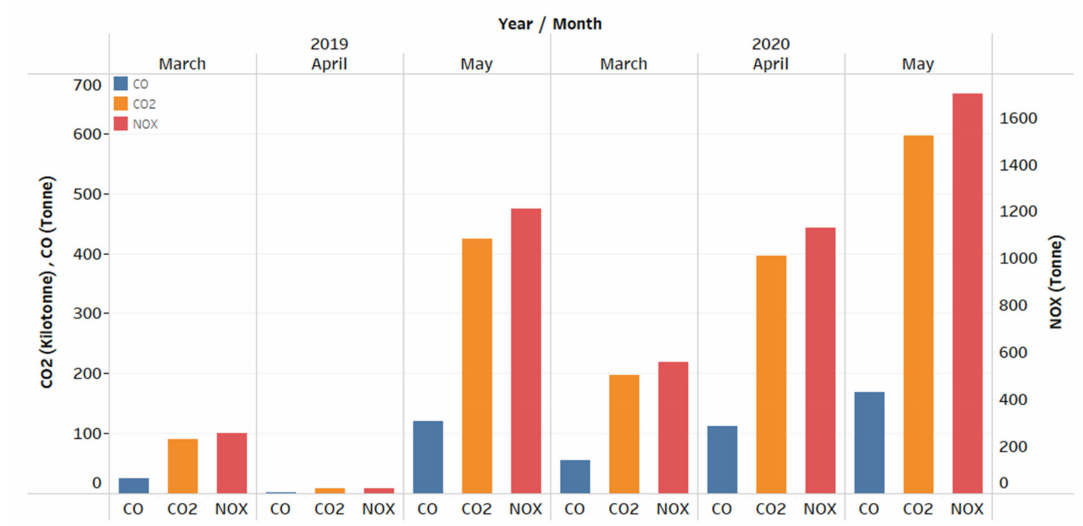
Figure 10. Decrease in emissions of CO 2 , NO x and CO pollutants over the period of partial and full